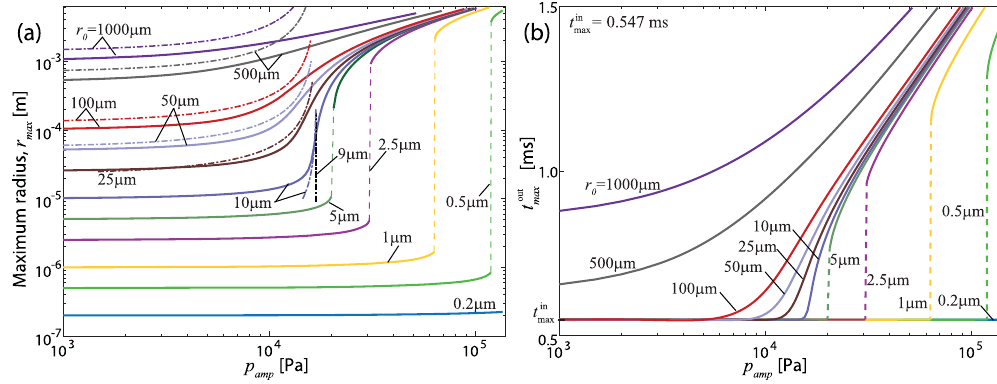
Figure 6. ( a ) The maximum radius ( r max ) and ( b ) corresponding time ( t ) maxout as a function of the amplitude of acceleration-induced input pressure ( p amp ) for an air bubble with an initial radius ranging from 0.2 μ m to 1000 μ m. Dash-dot lines and solid/dashed lines are from the first order approximation (Eq. 6) and directly numerical simulation (Eq. 1),